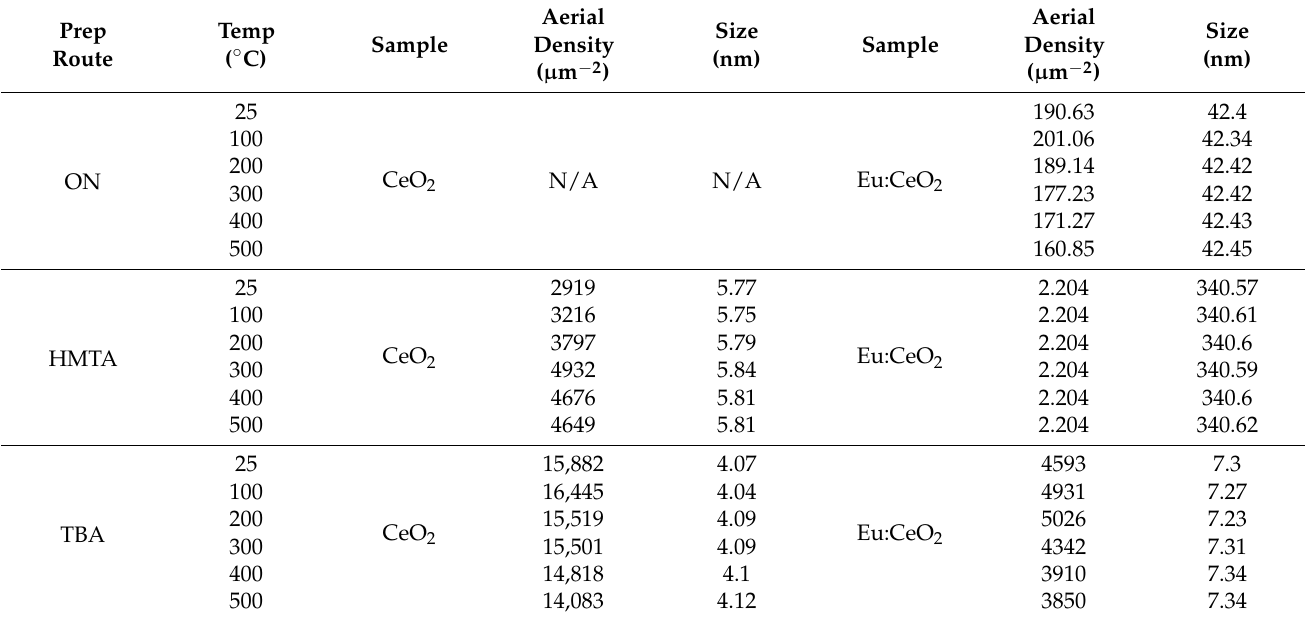
Table 2. Aerial density ( µ m − 2 ) and size (nm) versus temperature ( ◦ C) for ( a ) ON, ( b ) HMTA, and ( c ) TBA preparation of CeO 2 and Eu:CeO 2